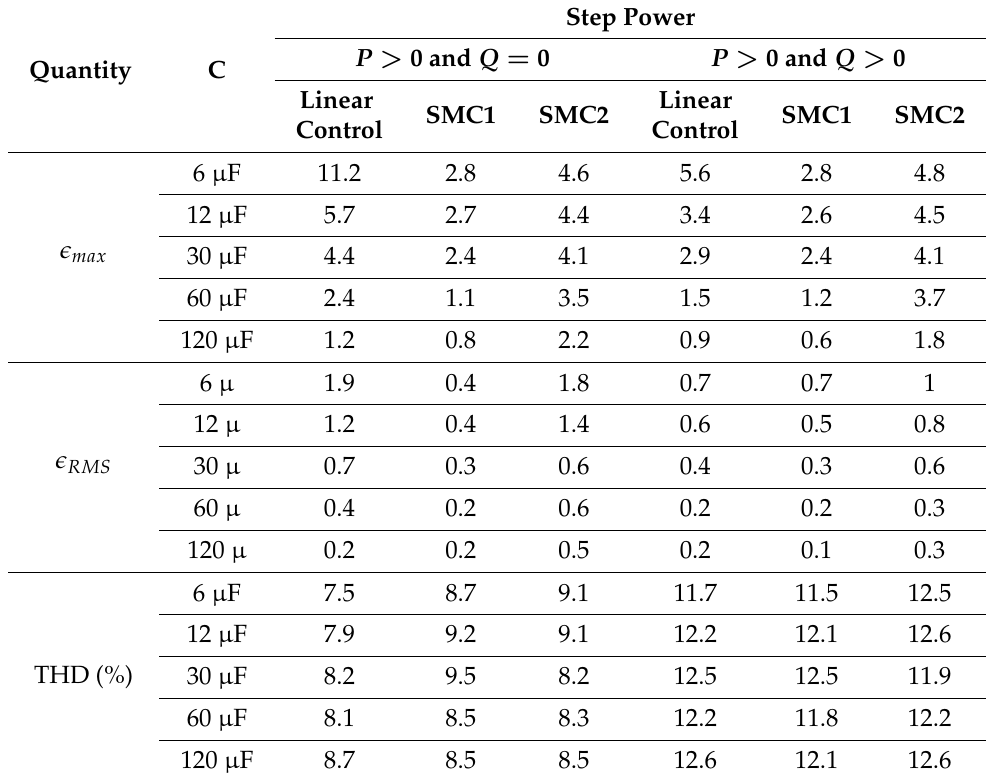
Table 5. Comparison of the errors, (cid:101) max and (cid:101) RMS , and the THD line current obtained by the three algorithms in the case of step power under a real